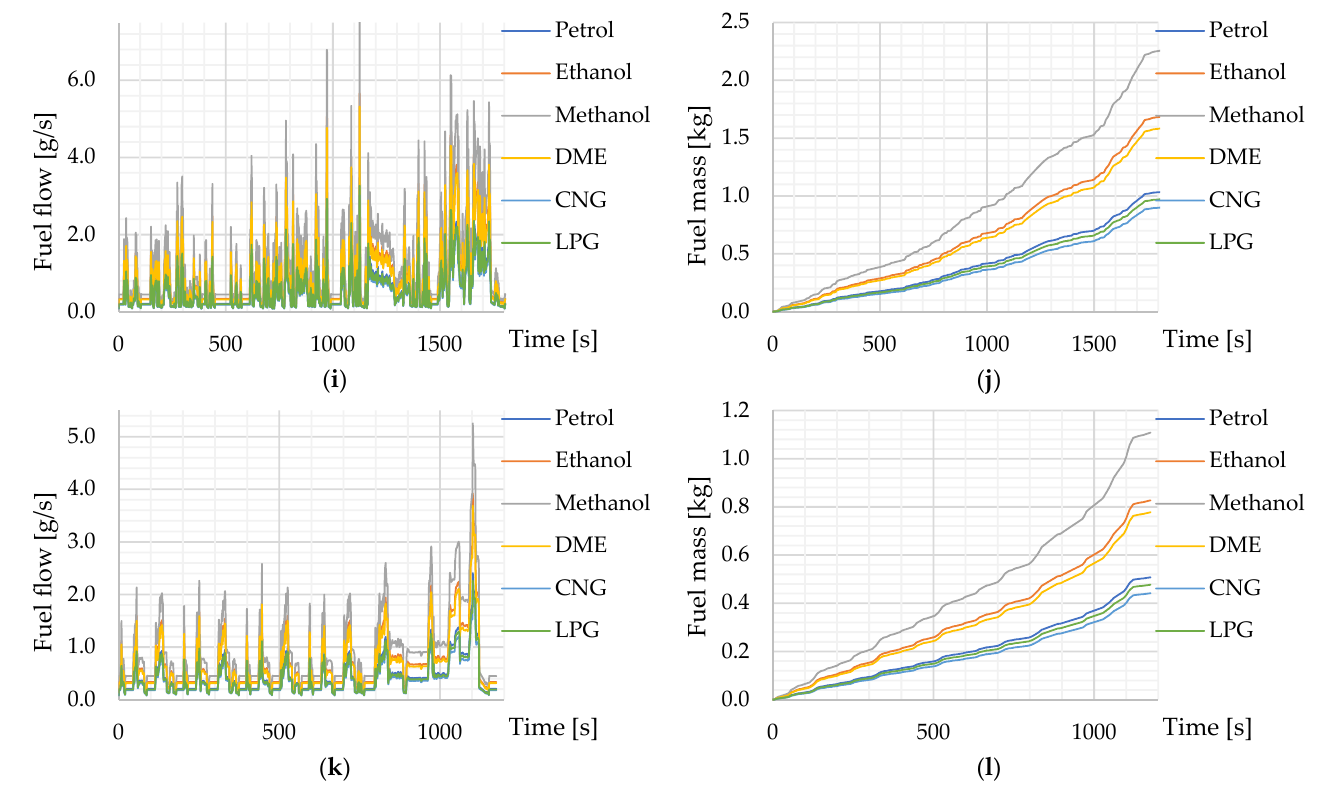
Figure 11. 2018 Toyota Camry LE—waveforms of instantaneous values: ( a ) vehicle engine fuel stream obtained from UDDS road test simulation for selected fuels; ( b ) fuel consumption obtained from UDDS road test simulation for selected fuels; ( c ) vehicle engine fuel stream obtained from HWFET road test simulation for selected fuels; ( d ) vehicle fuel consumption obtained from HWFET road test simulation for selected fuels; ( e ) vehicle engine fuel stream obtained from US06 road test simulation for selected fuels; ( f ) vehicle fuel consumption obtained from US06 road test simulation for selected fuels; ( g ) the vehicle engine fuel flow obtained from LA92 road test simulation for se-